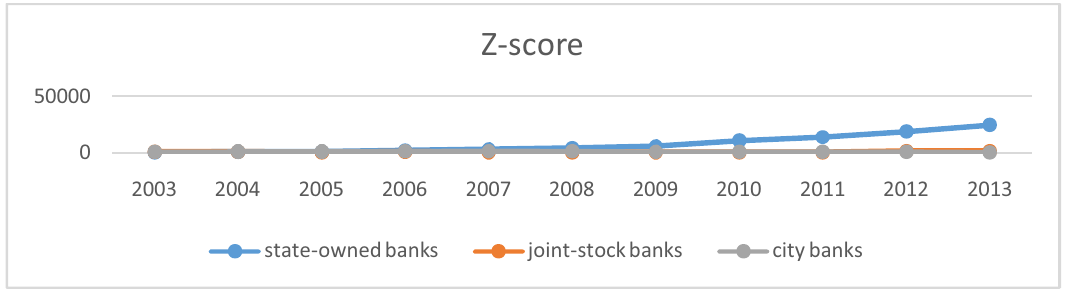
Fig. 1. The profitability of three different ownership types of Chinese commercial banks over the period 2003-2013